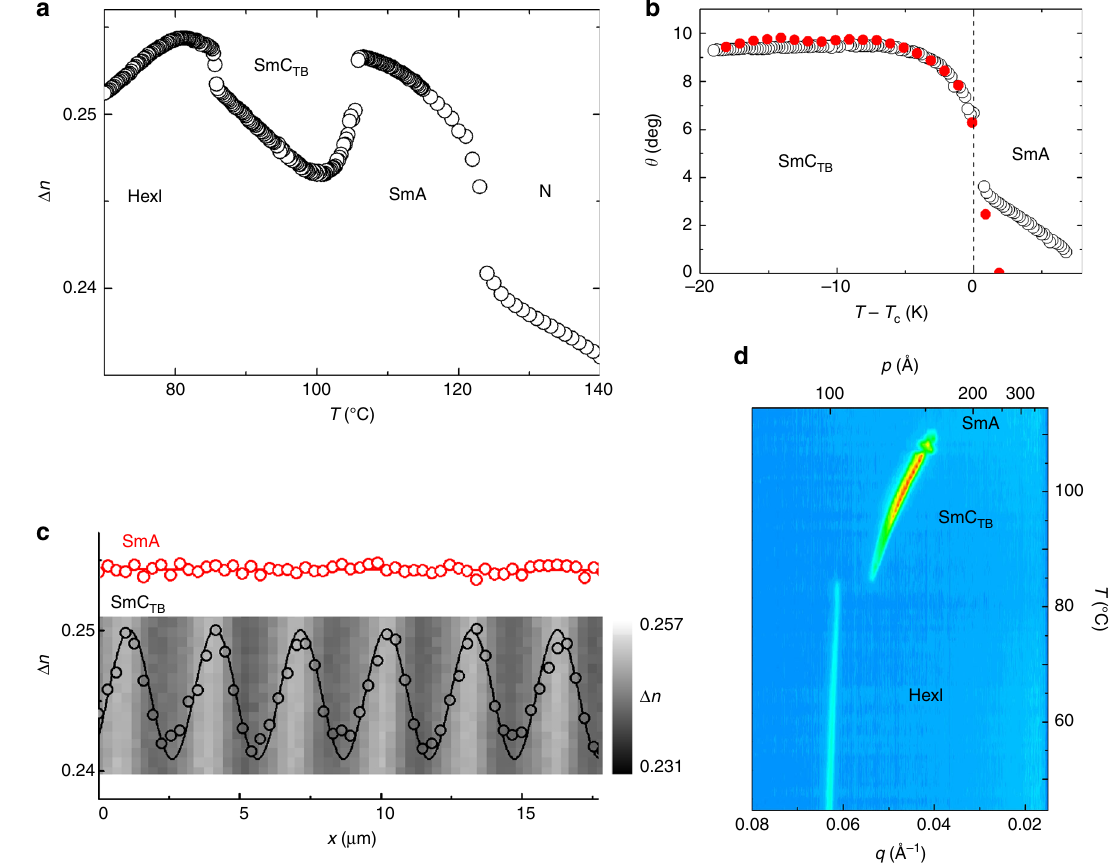
Fig. 4 Birefringence and helical pitch. a Temperature dependence of the optical birefringence, Δ n , for homologue CB6OIBeO7 measured in 3 μ m-thick cell with planar anchoring. b Dependence of the conical angle θ deduced from both birefringence (open circles) and X-ray measurements ( fi lled, red circles). c Changes of birefringence across the stripes shown in the background, revealing a decrease of Δ n in the SmC TB phase with respect to the orthogonal SmA phase owing to heliconical structure. d Temperature evolution of the resonant soft X-ray diffraction signal for the CB6OIBeO7 compound measured on cooling; whereas in the HexI phase the signal position is practically temperature independent (it corresponds to ~ 100 Å), in the SmC TB phase it changes strongly owing to the changes of the heliconical pitch length from 117 to ~ 150 Å close to the transition to the SmA phase. Note that the pitch dependence is monotonic, whereas the smectic layer spacing is a non-monotonic function of